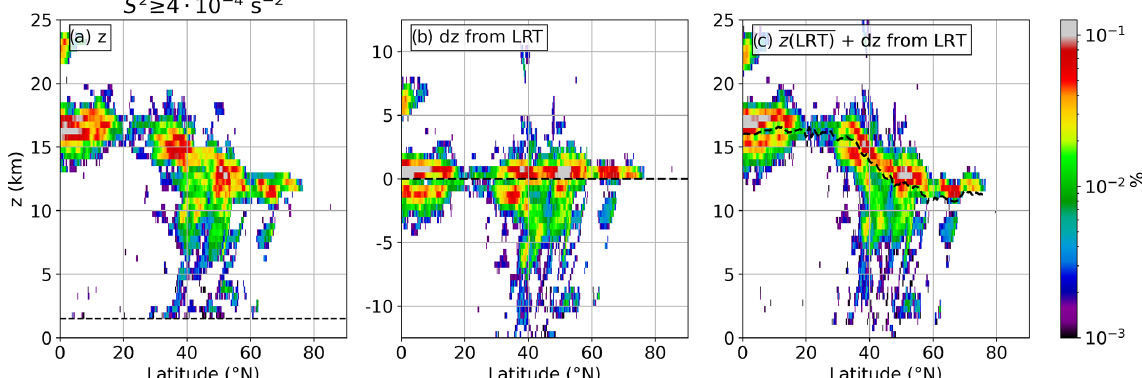
Figure 4. Relative occurrence frequency of S 2 ≥ S 2 t , zonally averaged over the Northern Hemisphere on 11 September 2017 at 00:00UTC. Logarithmic frequency contour, vertically binned in d z = 500m. (a) Geometric altitude as the vertical coordinate. Dashed black line indicates the effect of the cut-off of 1.5km above orography. (b) Relative distance from the LRT as the vertical coordinate. Dashed black line shows LRT altitude. (c) As in panel (b) but with mean LRT altitude for profiles with S 2 ≥ S 2 t restored (dashed bold black